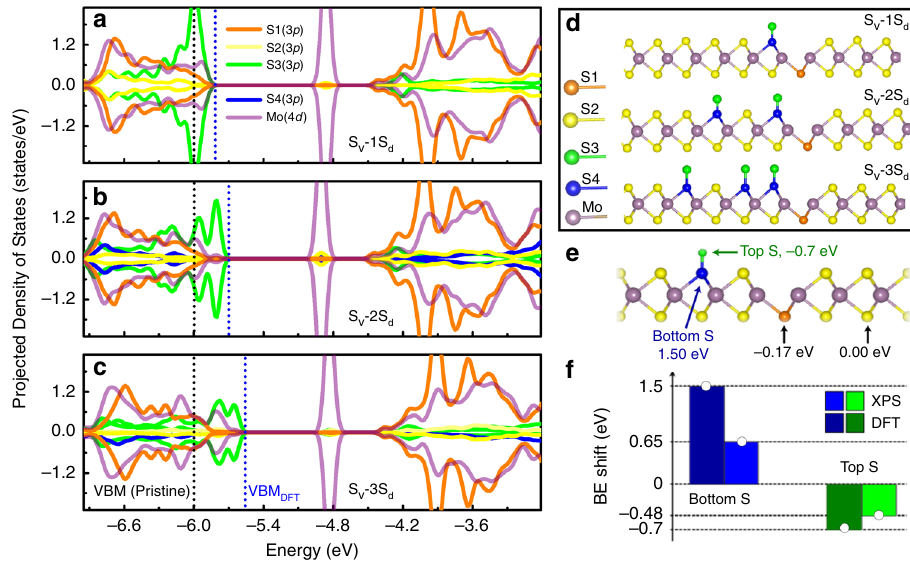
Fig. 3 DFT calculations. Atom normalized spin-polarized projected density of states (PDOS) of MoS 2 with one S vacancy and one (S v – 1S d ) ( a ), two (S v – 2S d ) ( b ), and three (S v – 3S d ) ( c ) protruding surface S atoms chemisorbed on the surface. The energy level of the valence band maximum (VBM DFT ) is calculated with respect to the vacuum level, and it is indicated by a blue dashed line, while the VBM of pristine MoS 2 is shown with a black dashed line and obtained from Ref 37 . d The schematic fi gures of the corresponding MoS 2 structures used in PDOS calculations. The S atom (S1) underneath a S vacancy, the regular S atom (S2), and the protruding S atom (S3) covalently bonded to a S atom on the surface (S4) are colored in orange, yellow, green, and blue, respectively. Mo atoms are represented by violet balls. e The core-level energy shifts of S 2 p states with respect to regular S atom (S2) (0.00 eV) are indicated. f Histogram of the DFT results (in dark blue and dark green) for the bottom (S4) and protruding S (S3) atoms with creation of a S vacancy together with the XPS energy shifts (in light green and light blue) of the two additional doublets used for the fi